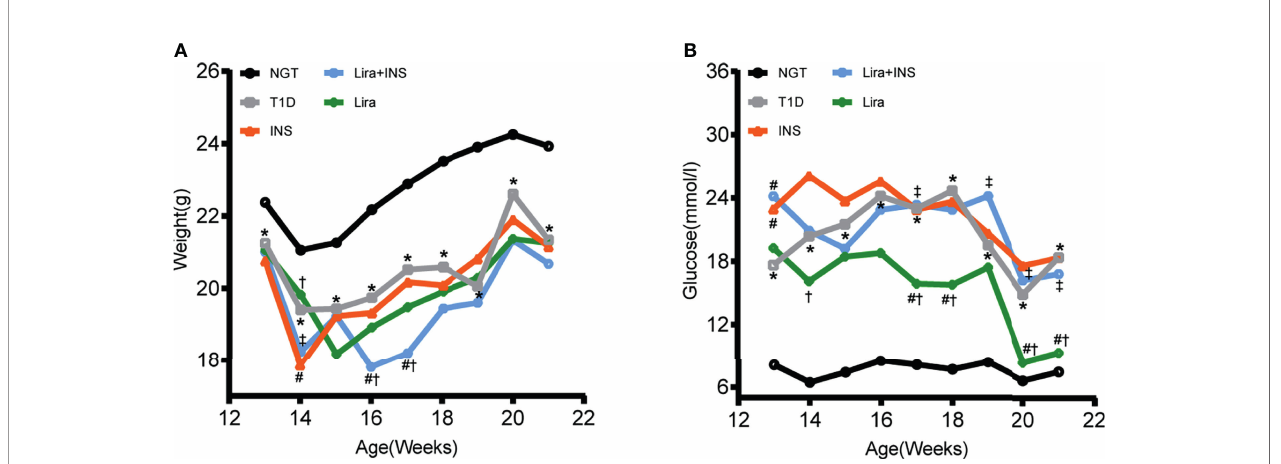
FIGURE 1 | Changes of body weight and blood glucose during treatments. (A) Weekly body weight (g); (B) weekly blood glucose levels at fed states (mmol/l). NGT: normal glucose tolerance group; T1D, saline-treated type 1 diabetes group; INS, insulin treatment group; Lira, liraglutide treatment group; INS+Lira, insulin + liraglutide treatment group; ANOVA was used for comparison between groups, and p < 0.05 was de fi ned as statistically signi fi cant. *compared with NGT; # compared with T1D; † compared with INS; ‡ compared with Lira. All data are expressed as mean ± SDs.